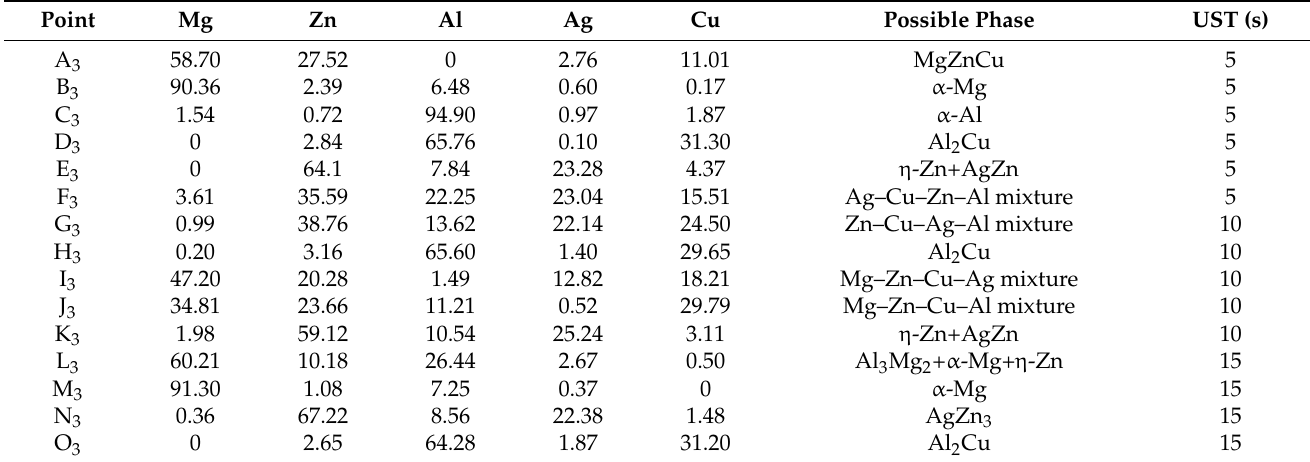
Table 3. Chemical composition of different regions shown in Figure 4